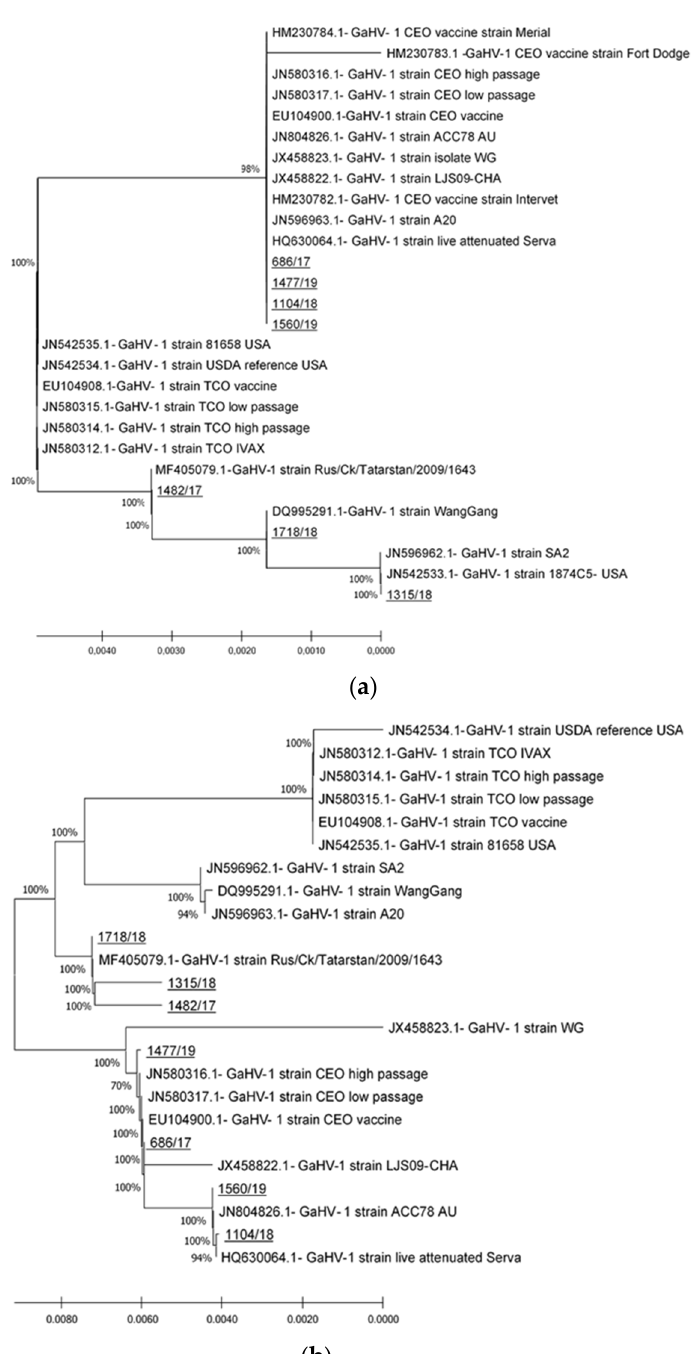
Figure 2. Phylogenetic relationships as calculated on partial ICP4 gene nt sequences of ILTV strains detected in Slovenia